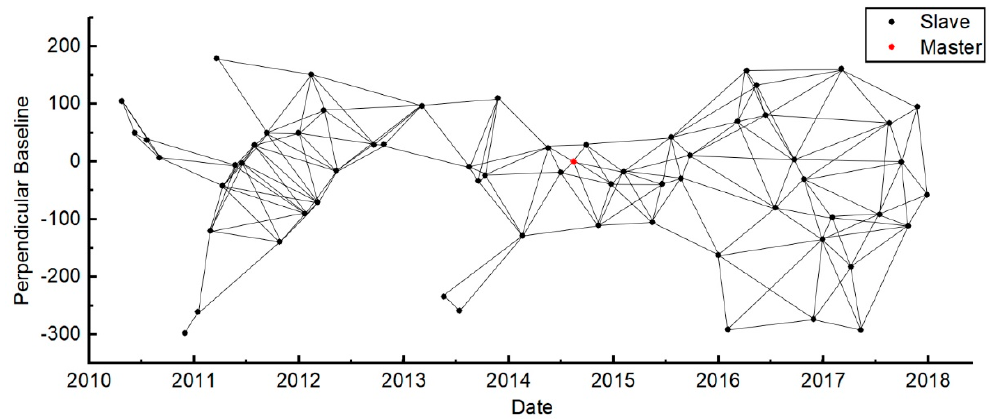
Figure 3. The spatial and temporal baseline distribution and interferogram pairs used in this paper. All the SAR images were spatially registered to the master image acquired on August 14, 2014.